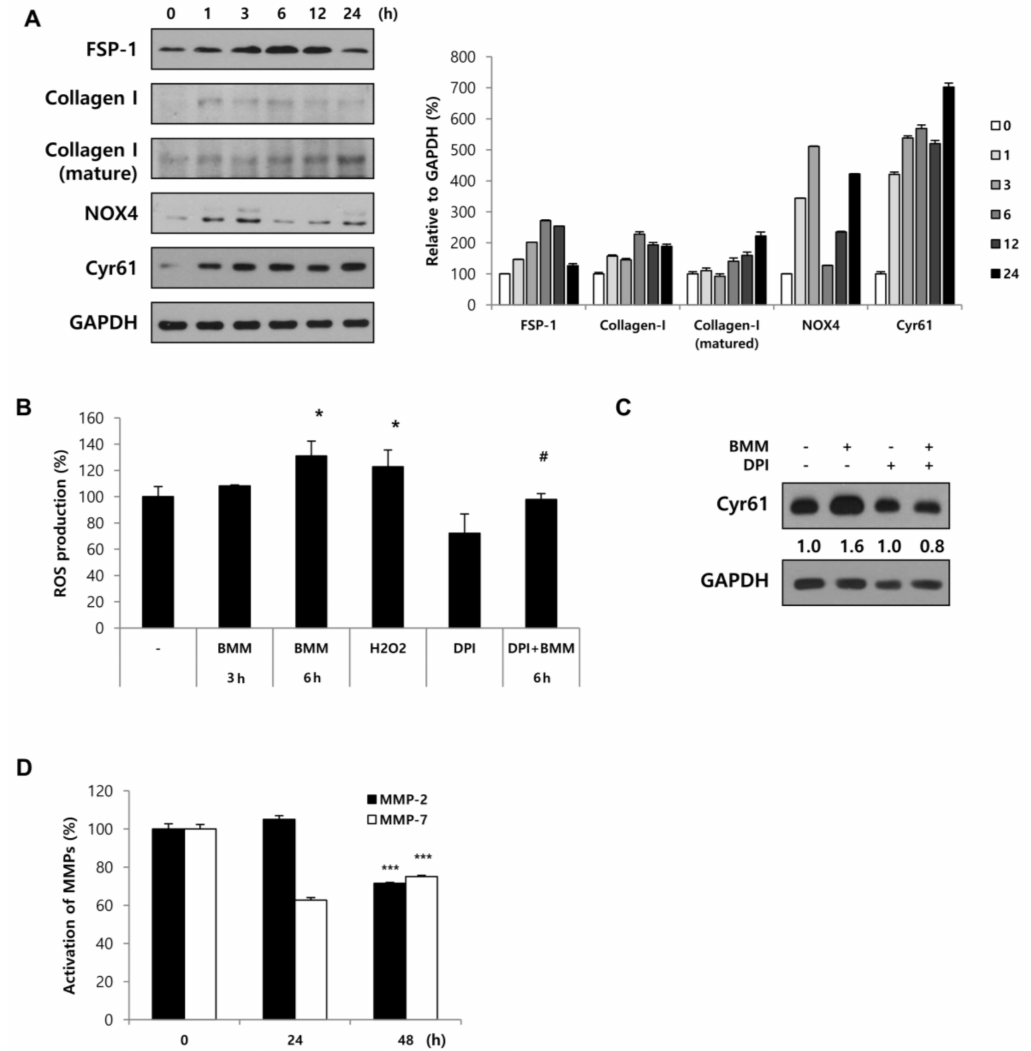
Figure 4. Fbs stimulated by BMM differentiate into myofibroblasts via the Cyr61/Nox4 pathway. ( A ) Western blotting for Fb differentiation, involving analysis of specific factors such as FSP-1, NOX2, NOX4, collagen-1, and Cyr61. The expression of these factors was normalized to that of GAPDH; ( B ) Cells were treated with BMM for 3 or 6 h or DPI (5 µ M; NOX inhibitor) for 1 h or were co-treated with DPI and BMM. ROS production was measured using the DCF-DA assay and calculated as a percentage of the mean fluorescence intensity compared with that of the control. * p < 0.05 as compared to the control; # p < 0.05 as compared to the BMM (6 h)-treated group; ( C ) Cells were treated with BMM for 3 h or DPI (5 µ M, NOX inhibitor) for 1 h or were co-treated with DPI and BMM. Cyr61 expression was normalized to that of GAPDH after western blotting. The values indicate intensities of protein expression with respect to that of the loading control; ( D ) Secretion of MMPs from BMM-treated-Fbs by using conditioned medium, followed by western blotting analysis. The expression levels were normalized to PonceauS, used as a loading control. *** p < 0.001 as compared to the